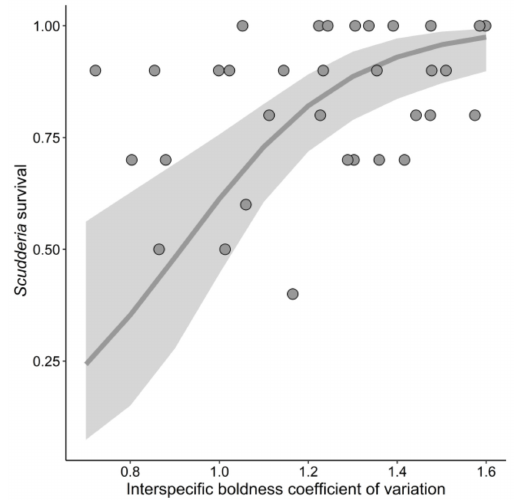
Figure 3. Indirect e ff ect of prey community boldness variance on Scudderia proportional survival across all spider predator treatments. Field mesocosms were stocked with 10 Scudderia individuals, and community boldness variance was calculated as the coe ffi cient of variation in boldness all prey species ( Philaenus , Orchelimum , Athysanus ) minus the focal species Scudderia . Shaded areas around marginal e ff ect regression line represent 84% confidence intervals generated using the “ggpredict” function in the R package “gge ff ects”